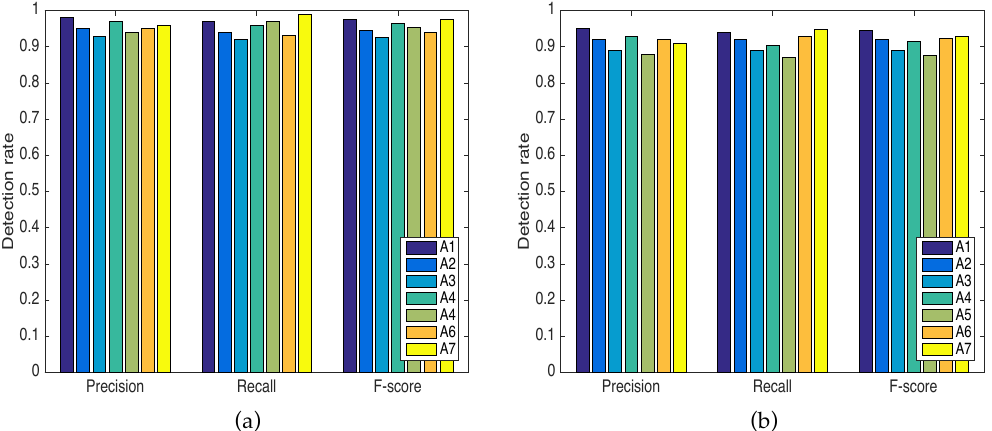
Figure 6. Precision, recall, and F-measure results. ( a ) The results of precision, recall, and F-measure